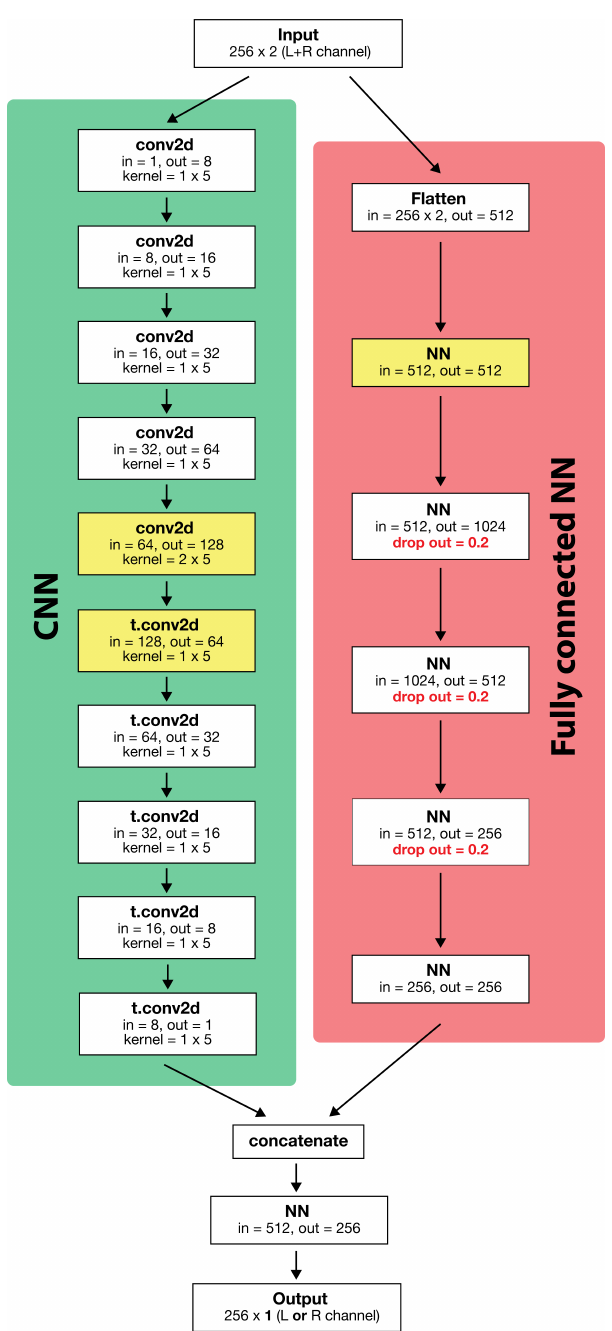
Figure 6. Baseline model, smaller model (smaller model removes the layers highlighted in yellow) and proposed model (proposed model uses drop out in some NN layers, shown in red, amongst other techniques discussed in Section